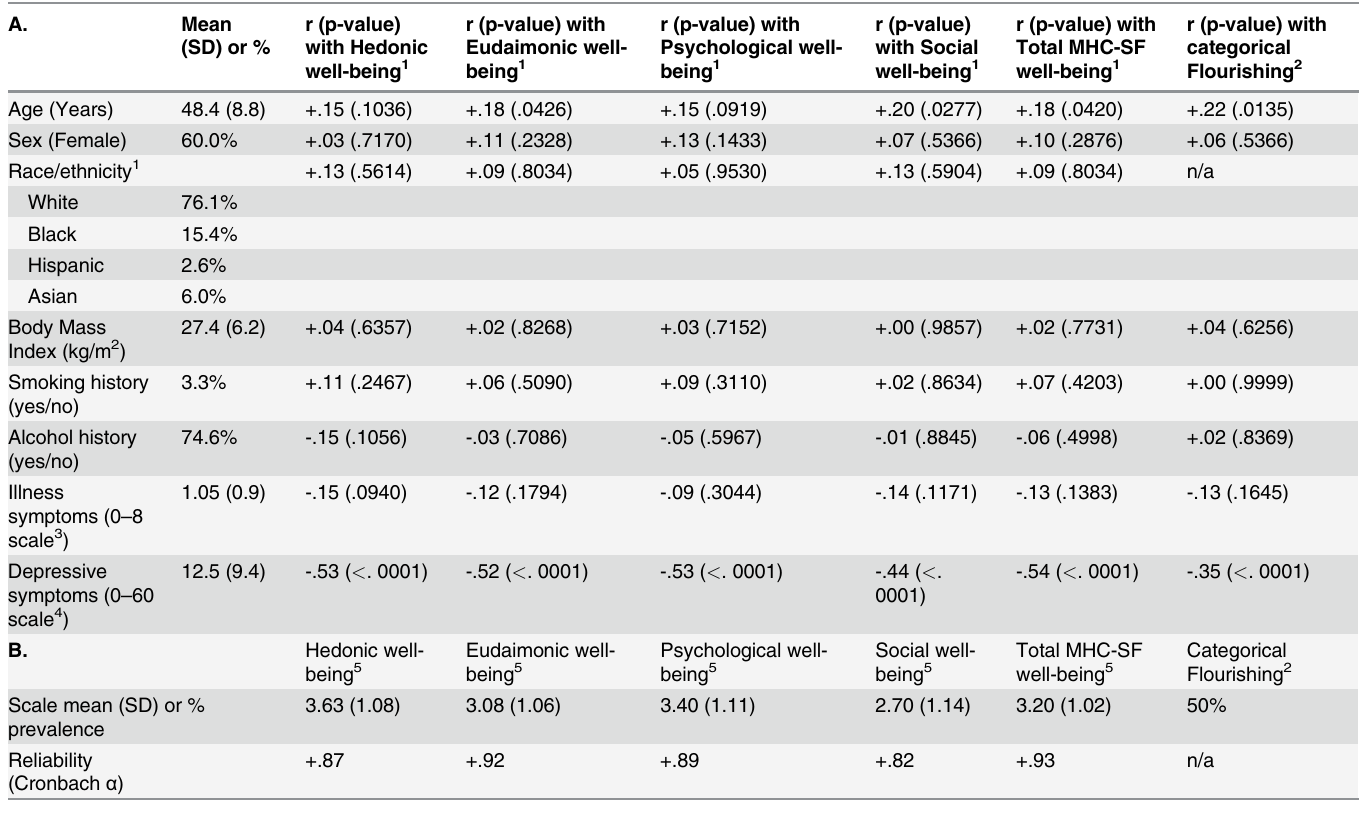
Table 1. Confirmation Study Sample